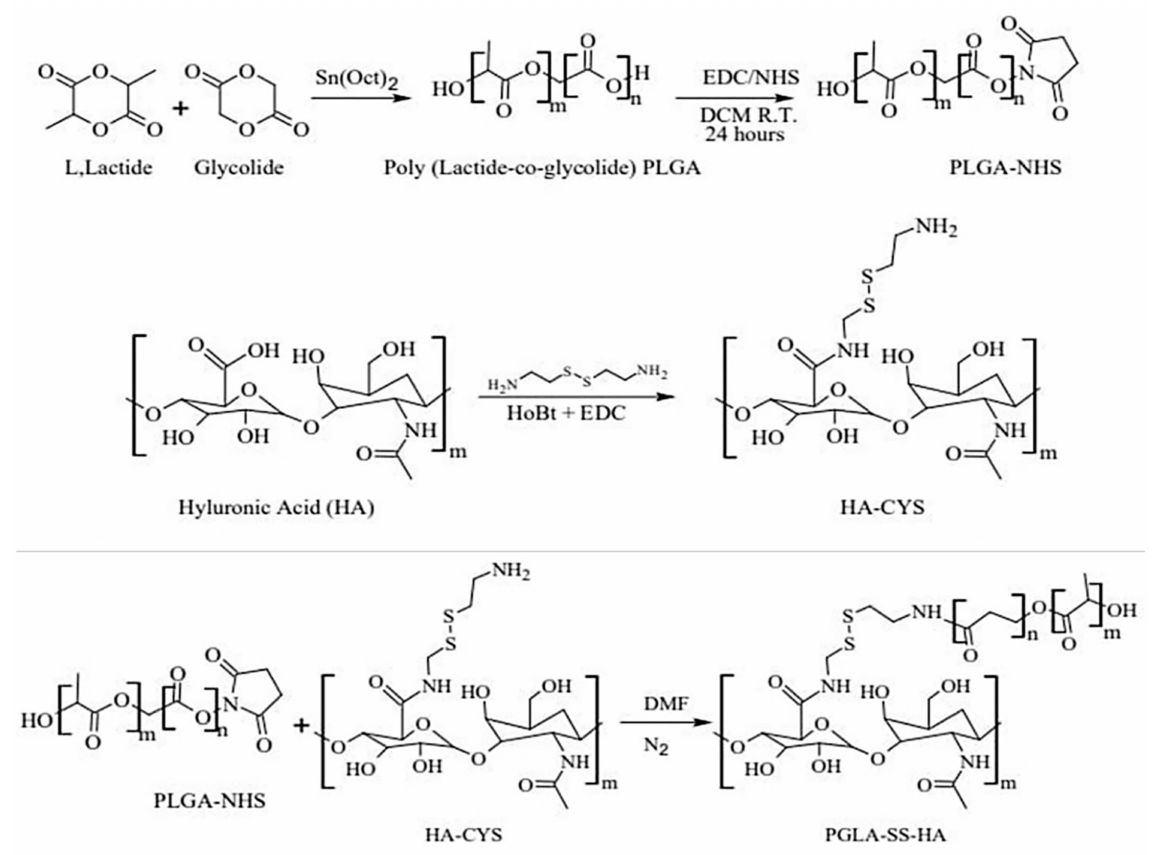
Figure 1. Synthesis scheme for hyaluronic acid-targeted poly (lactide) co (glycolide) (HA-ss-PLGA) graft